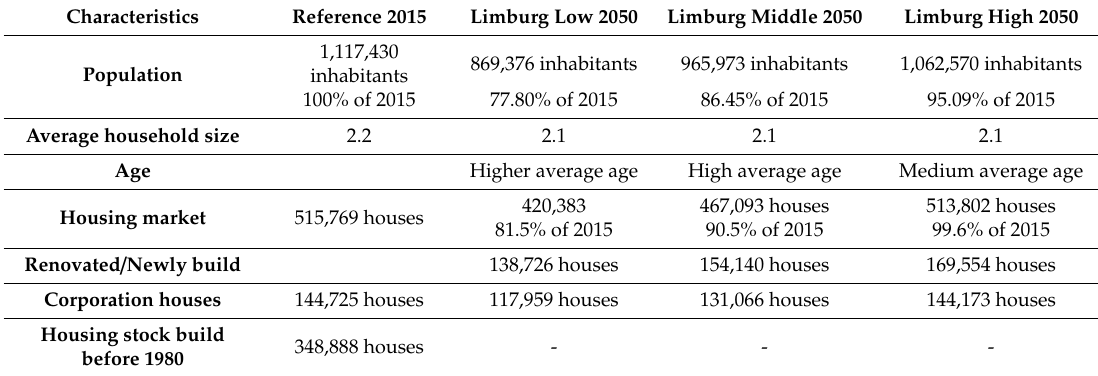
Table 5. Demographic scenarios.